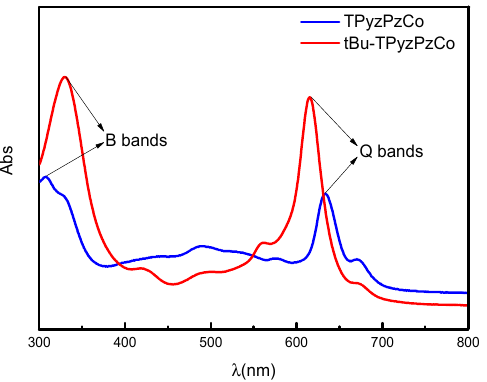
Figure 1. UV-visible absorption spectra of unsubstituted TPyzPzCo (blue) and t Bu-TPyzPzCo (red) in DMF solution.